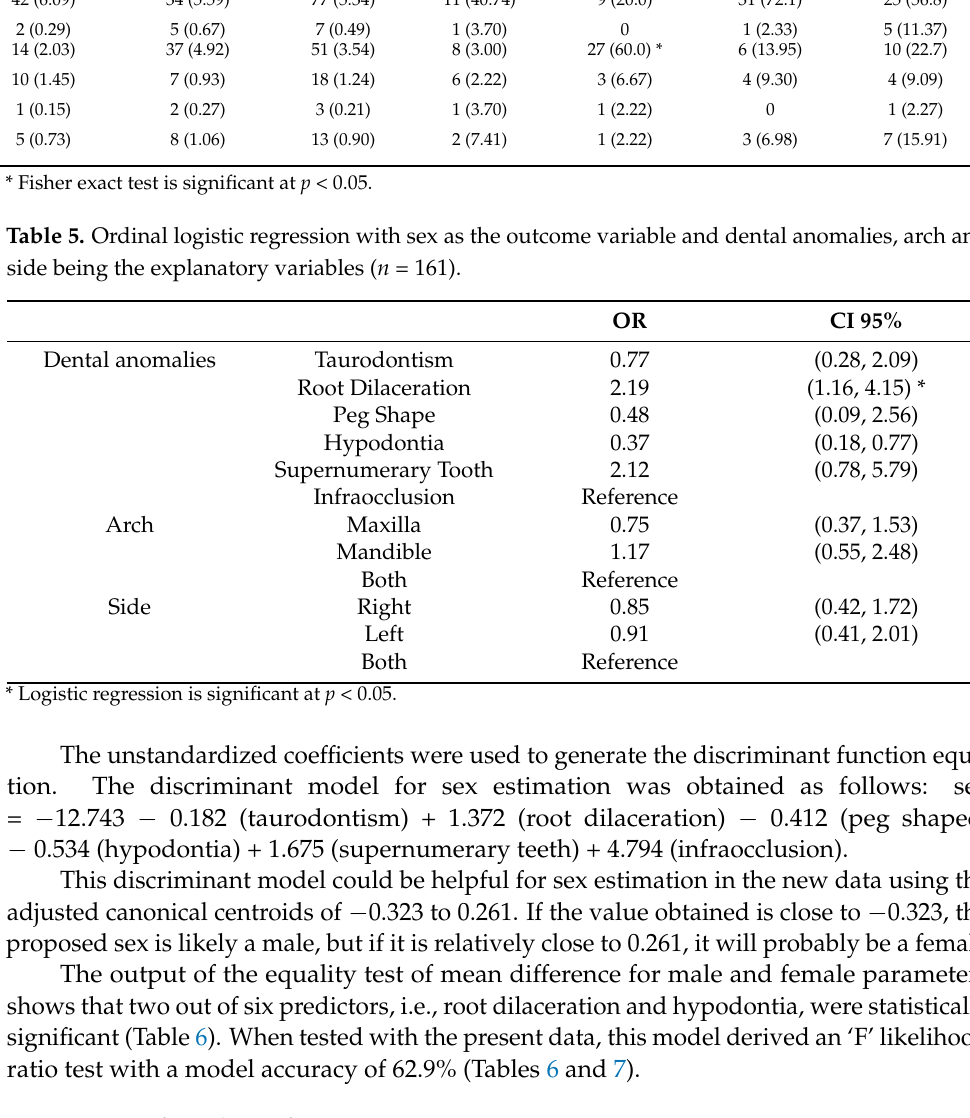
Table 6. Tests of equalities of group